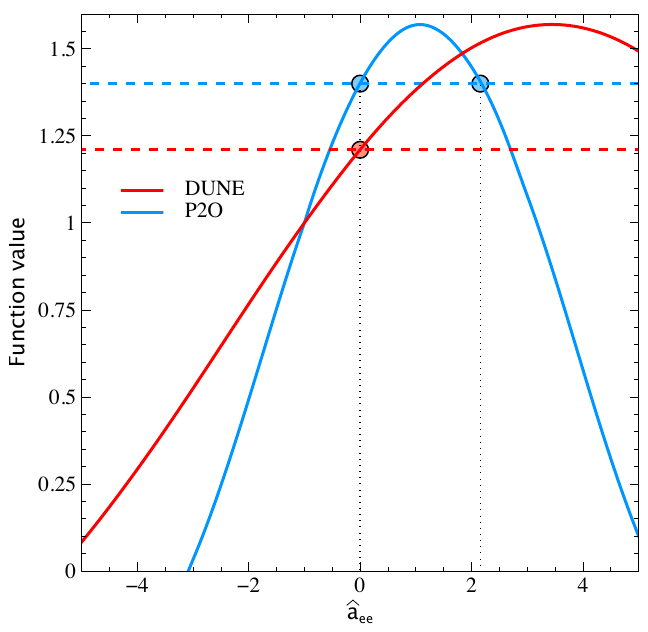
Figure 3 . The two terms in I − from eq. (3.12) are plotted for both DUNE (red) and P2O (blue) as functions of the parameter ˆ a ee = a ee / while the dashed curve is the second term of solutions where the two terms